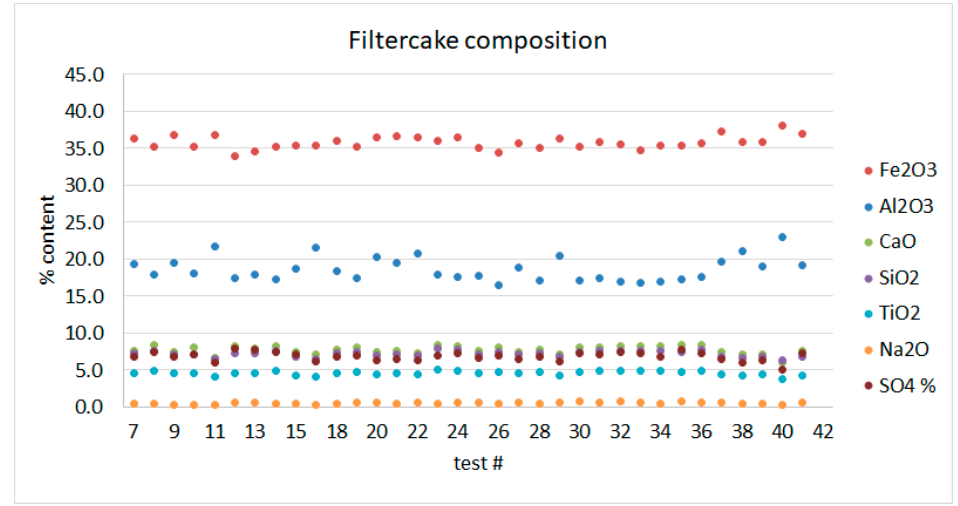
Figure 1. Top: XRD comparisons of bauxite residue and leached bauxite residue (filter cake). Phases identified 1: Hematite (Fe 2 O 3 ), 2, Cancrinite (H 0.88 Na 8 Al 6 (SiO 4 ) 6 (CO 3 ) 1.44 (H 2 O) 2 ), 3, Diaspore (AlO(OH), 4, Gibbsite (Al(OH) 3 ), 5, Boehmite (AlO(OH)), 6, Perovskite (Ca(TiO 3 )), 7, Calcite (Ca(CO 3 )), 8, Katoite (Ca 3 Al 3.5 O 4.5 (OH) 7.5 ), 9, Goethite (FeO(OH)), 10, Rutile (TiO 2 ), 11, Anatase (TiO 2 ), 12, Quartz (SiO 2 ), 13, Chamosite ((Mg 1.5 Fe 7.9 Al 2.6 )(Si 6.2 Al 1.8 O 20 )(OH) 16 ), 14, Bassanite (Ca 2 (SO 4 ) 2 (H 2 O)).; Bottom: XRF analysis of leached bauxite residue (filter cake). Table 1. BR’s Chemical composition.